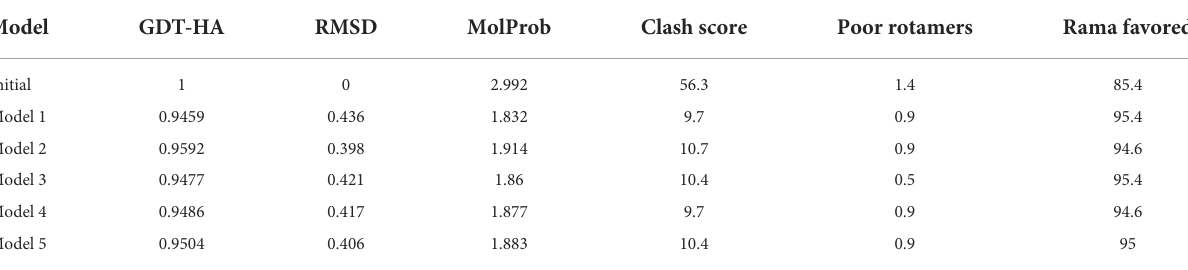
TABLE 3 Galaxy refined models with their properties.